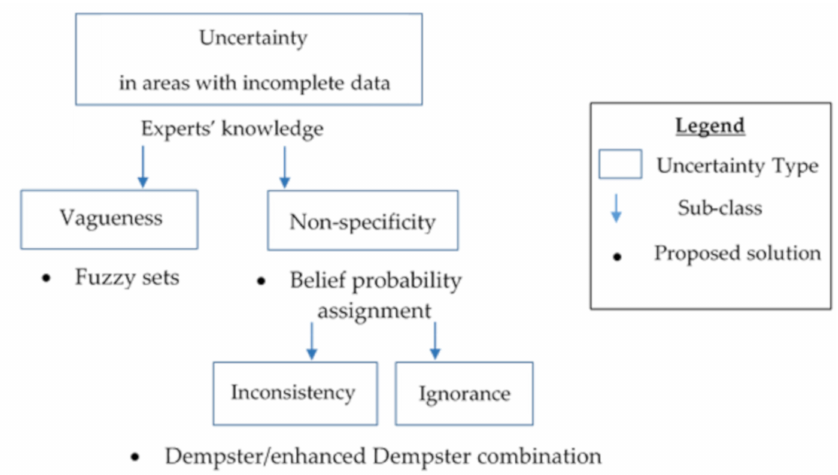
Figure 1. Analysis of incorporated epistemic uncertainties and the methods proposed for modelling them